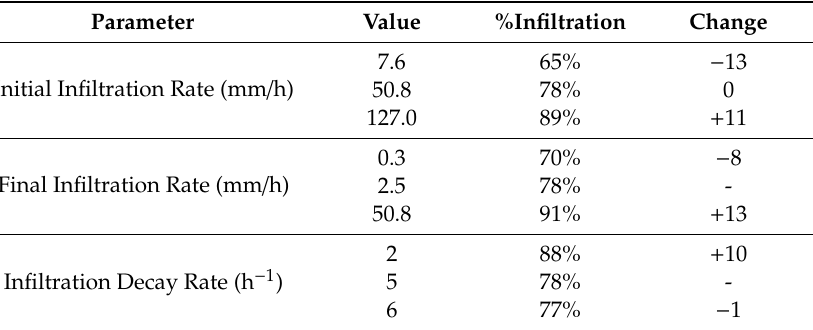
Table 2. Soil parameter sensitivity results.